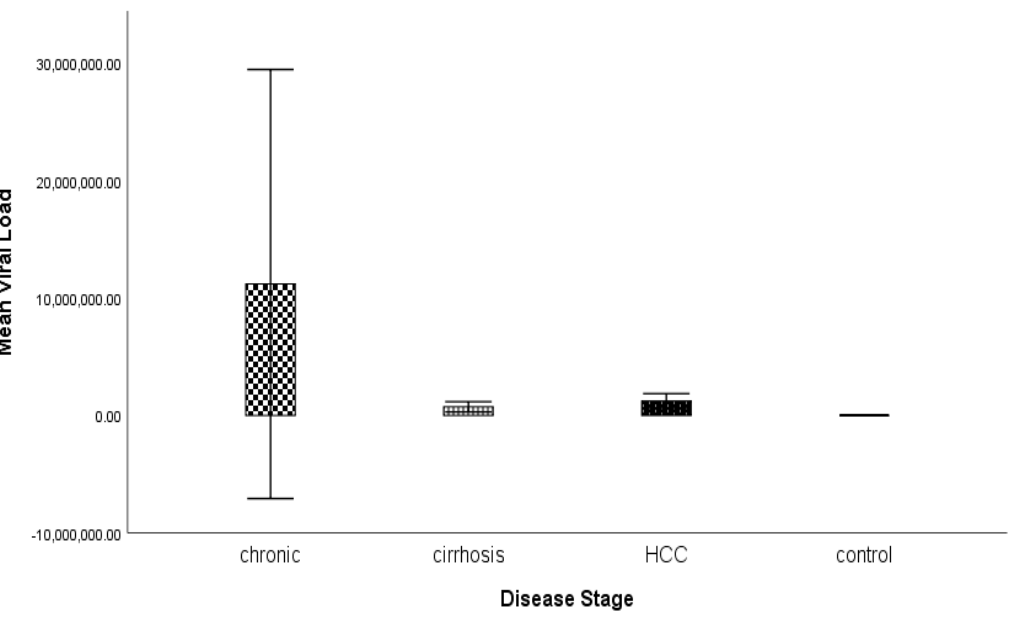
Figure 2. Graphical representation of analysis of variance in viral load level among the chronic, cirrhosis, HCC, treated, and control groups.